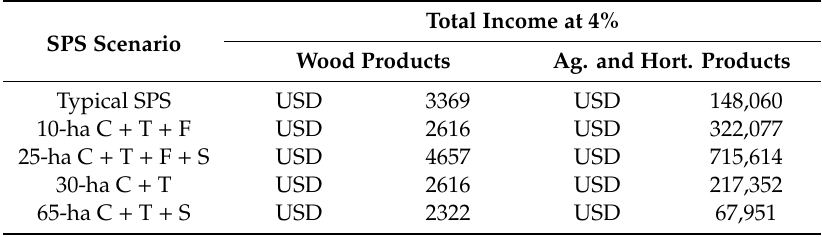
Table 2. Total present value income by product type (discounted at 4%).